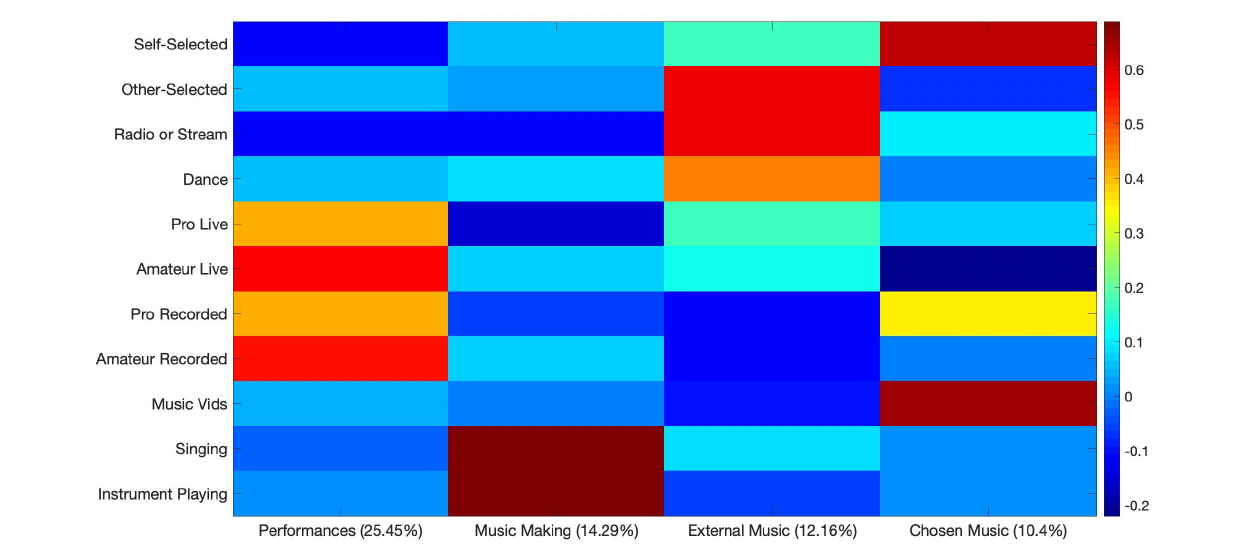
FIGURE 7 | Varimax-rotated PCA solution for MMR scores. Three components account for a collective 81.83% of the variance. TABLE 1 | Correlation of PC